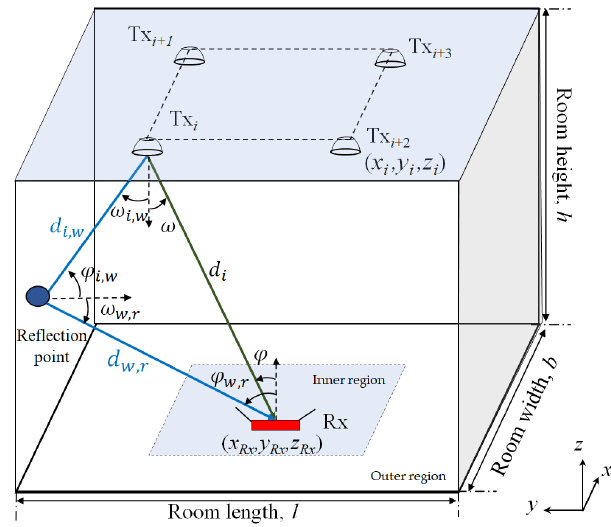
Figure 1. A VLP system with system configuration.